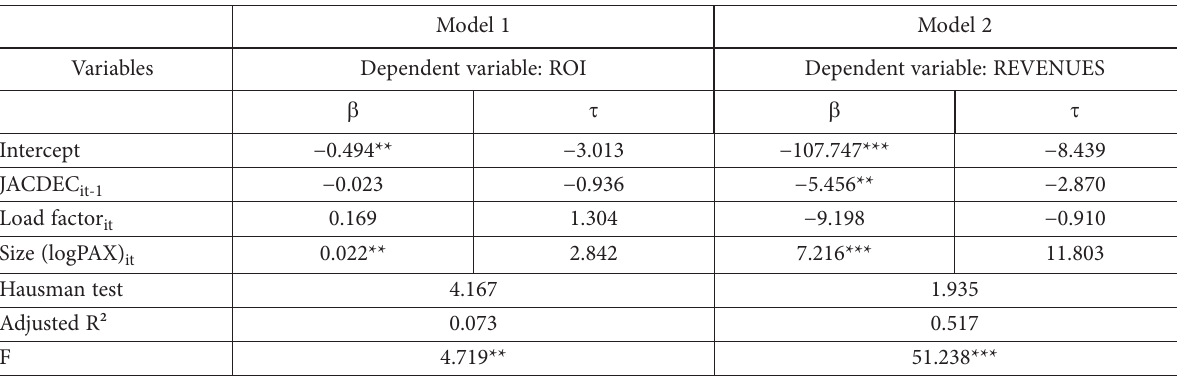
Table 3. Estimation models 1 and 2